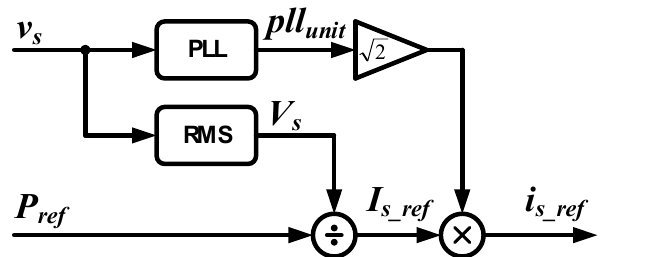
Figure 12. Block diagram of the reference current calculation in V2G slow battery-charging mode (based on [47]).